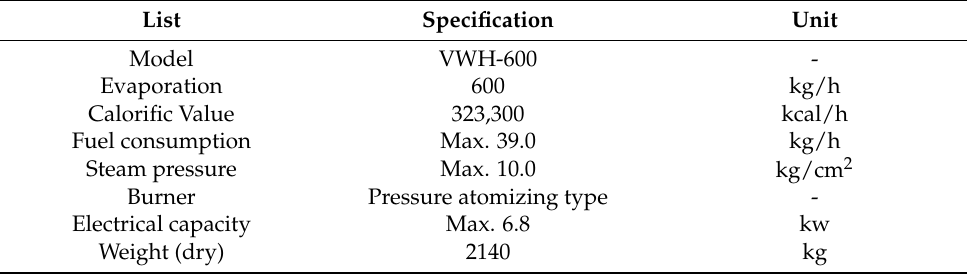
Table 2. Marine boiler